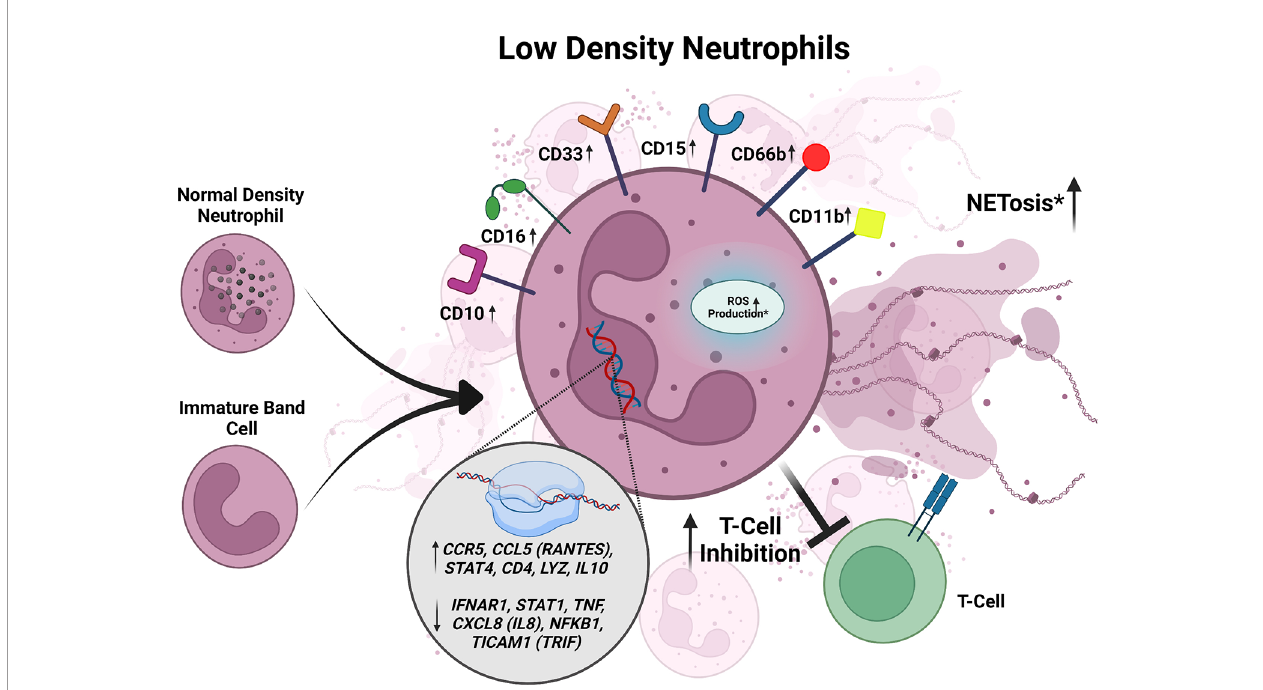
FIGURE 2 | Summary of characteristics of LDNs described in active TB. LDNs may be derived from NDNs or an unknown neutrophil progenitor. In active TB, LDNs express increased CD10, CD11b, CD15, CD16, CD33, and CD66b. When exposed to Mtb in vitro , LDNs exhibit inhibition of T cell responses. LDNs have also been shown to exhibit higher levels of NETosis and ROS production in response to Mtb infection when compared to NDNs, but the data for these responses is inconsistent between studies and requires further investigation. LDNs also have increased expression of CCL5 , STAT4 , CD4 , LYZ , IL-10 , IFNAR1 , STAT1 , CCL5 (RANTES) , STAT4 , TNF , and CXCL8 . Con fl icting data is designated by